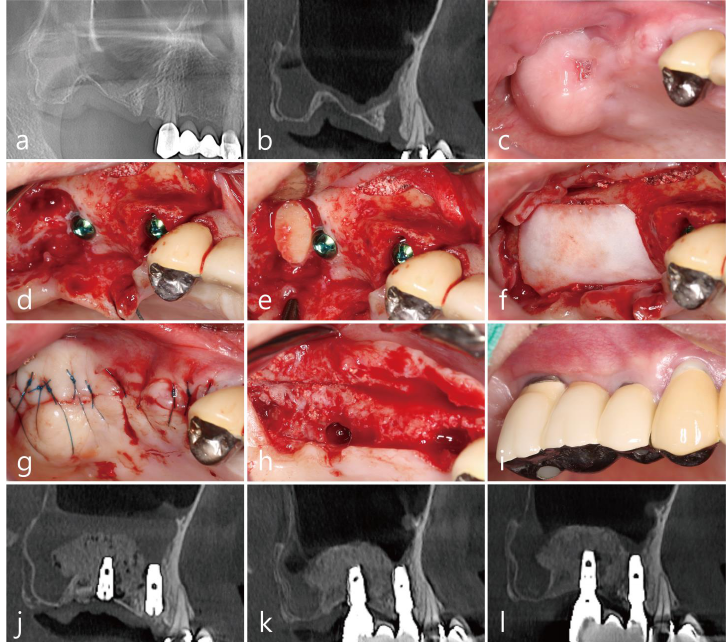
Figure 1. Case 1: ( a ) preoperative panoramic radiograph; ( b ) sagittal image of the preoperative CBCT scan showing a severely resorbed bone defect; ( c ) preoperative clinical view two months after tooth extraction; ( d ) after the flap reflection, a lateral window was prepared, and the buccal bony window was obtained during the maxillary sinus augmentation; ( e ) the obtained lateral bony win- dow was passively placed on the distal intraosseous defect of the #17 implant without fixation; ( f ) the surgical site was covered with a resorbable collagen membrane; ( g ) the flaps were closed with minimal tension; ( h ) the uncovering procedure was performed six months after the operation, and the lateral window bone was well incorporated with the adjacent native bone; ( i ) clinical view at two years after prosthesis delivery; ( j ) panoramic radiograph immediately after surgery; ( k ) sagittal image of the CBCT scans after prosthesis delivery; ( l ) sagittal image of the CBCT two years after prosthesis delivery, where the lateral bony window was well incorporated with the surrounding native bone, and the bone density was increased.